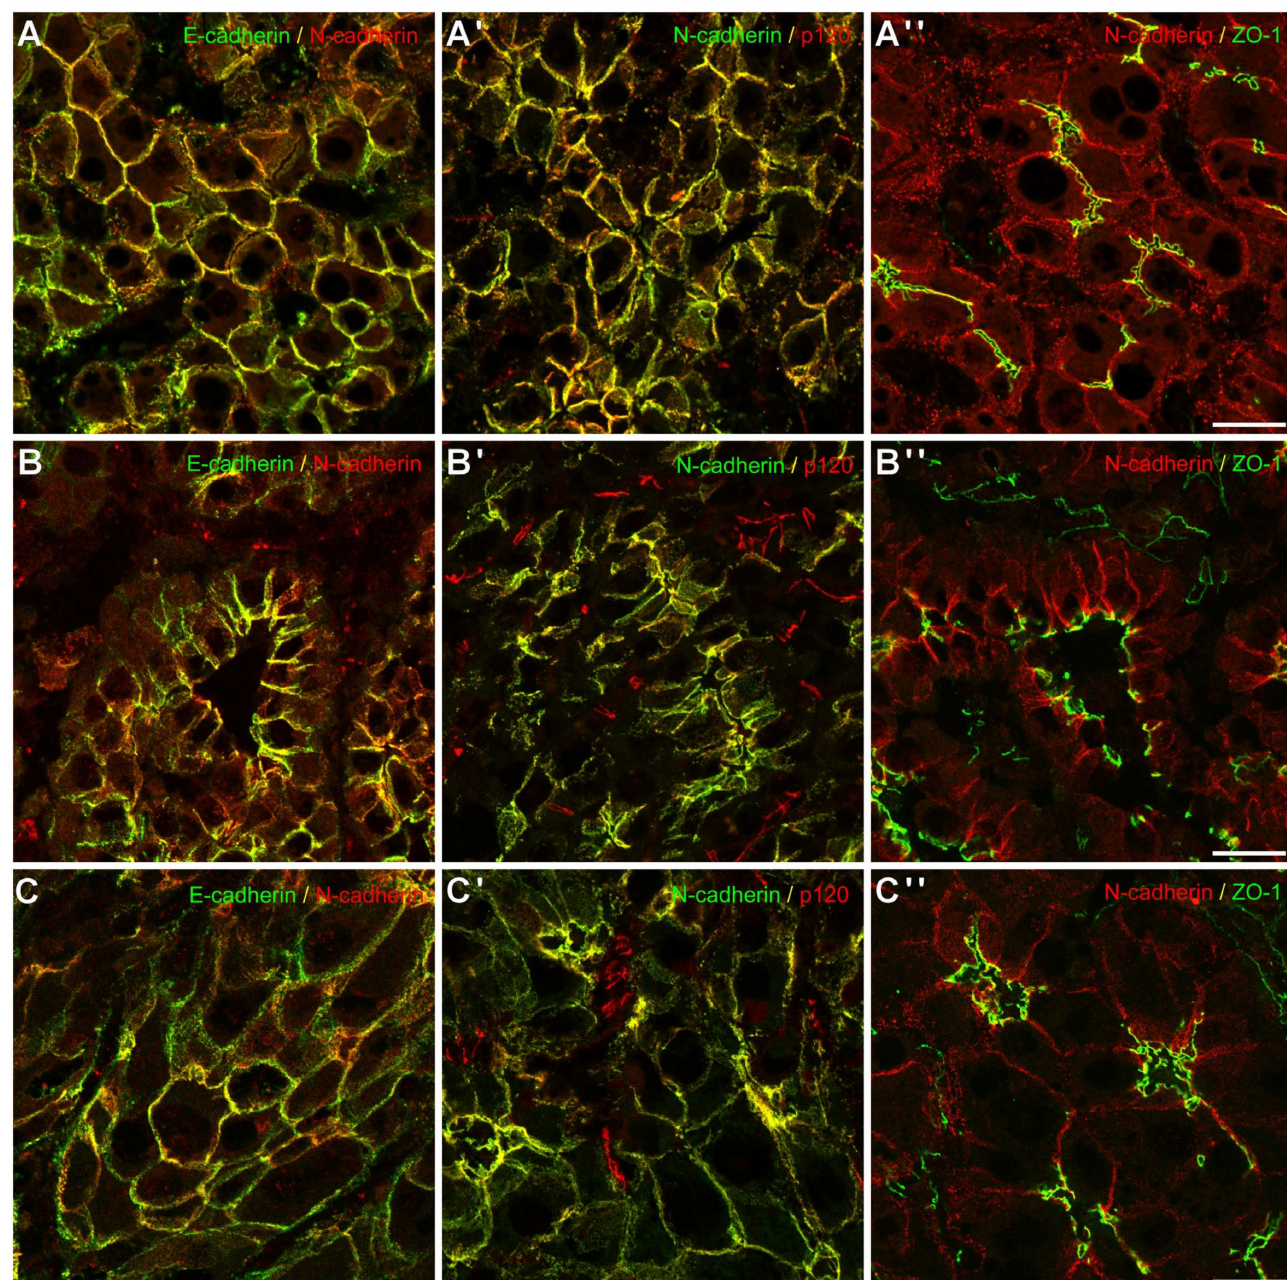
Figure 4. Immunofluorescence microscopy of components of junction components in grades 1, 2, and 3 HCC. E- and N-cadherin are colocalized in well ( A ), moderately ( B ), and poorly ( C ) differentiated HCC, together with the plaque protein p120-ctn ( A (cid:48) – C (cid:48) ). In normal liver tissue, tight junction protein ZO-1 is an indispensable component of the hepatic barrier and is required for apical polarity. In HCC, protein ZO-1 demonstrates the disruption of the cell polarity ( A (cid:48)(cid:48) – C (cid:48)(cid:48) ). Note also staining of N-cadherin as well as p120-ctn and protein ZO-1 in the small vessels. Bar: 20 µ